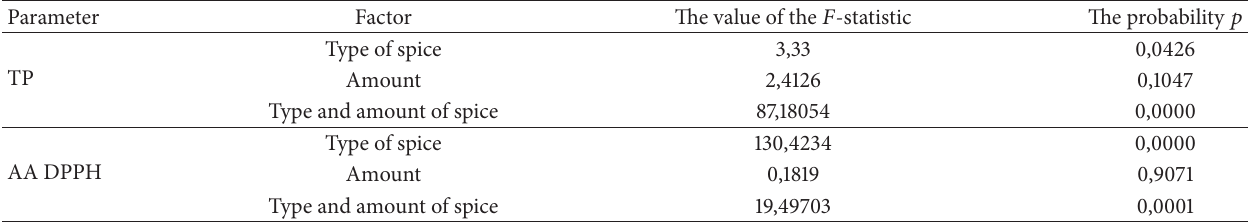
Table 3: The effect of selected factors on antioxidant activity of honey, in the multivariate tests of significance. Parameter Factor The value of the 𝐹 -statistic The probability 𝑝 Type of spice 3,33 TP Amount Type and amount of spice Type of spice AA DPPH Amount 0,1819 0,9071 Type and amount of spice 19,49703